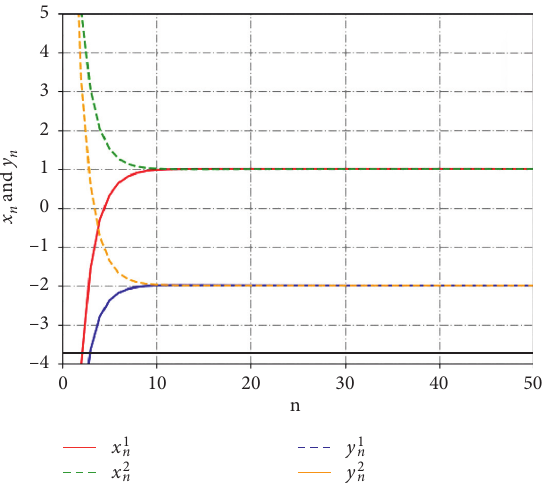
Figure 1: Convergence of x